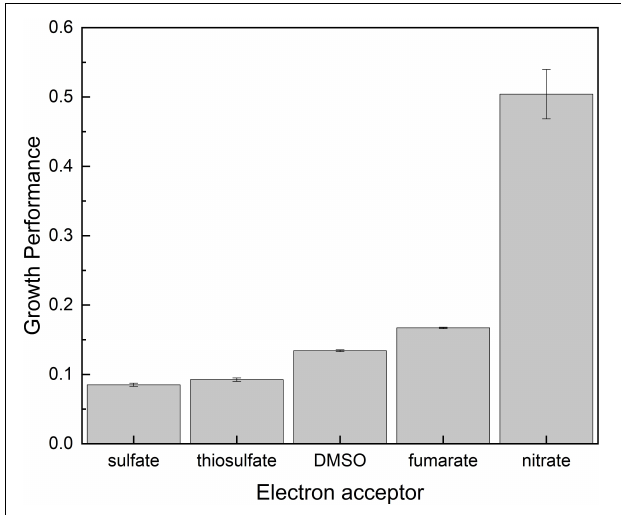
FIGURE 2 | Growth performance calculated as OD 600max /doubling time as related to the available electron acceptor on which consortia were developed.